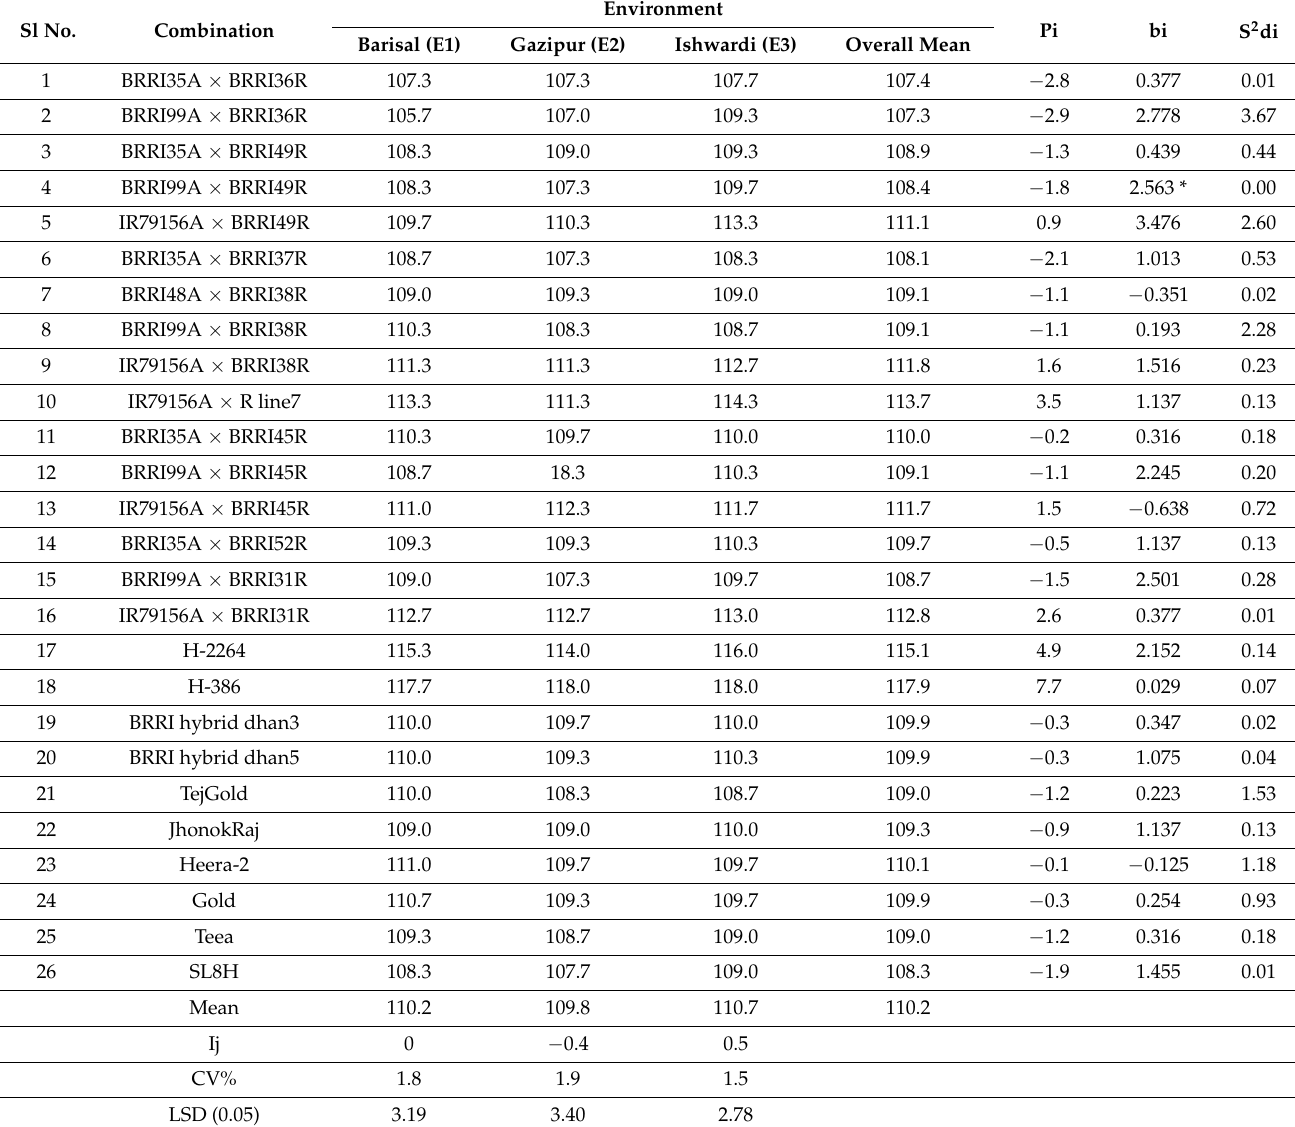
Table 5. Stability analysis for plant height of 26 hybrid combinations at three locations.